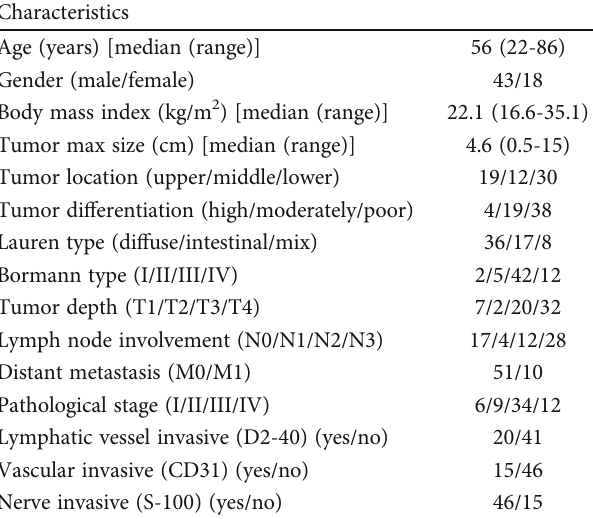
Table 1: Patient characteristics ( n = 61